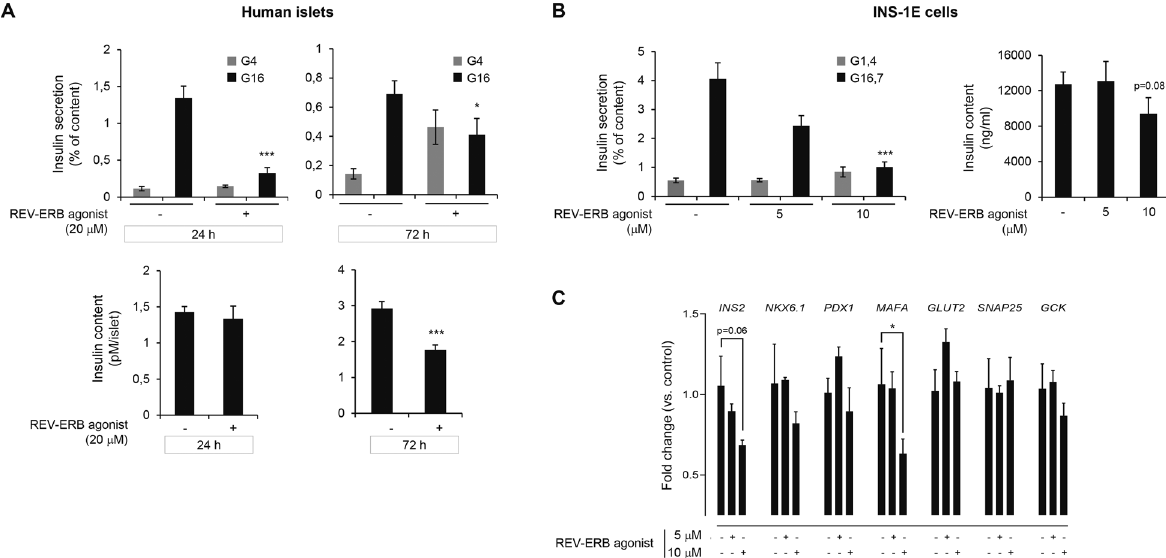
Fig. 5 Pharmacological activation of REV-ERB α attenuates β -cell secretory function. A Isolated human islets were exposed to REV-ERB agonist (SR9009, 20 μ M, for either 24 h or 72 h) or control (DMSO). Following a 30 min quiescent period in Krebs 4 mM glucose (G4), islets were stimulated with 16 mM glucose (G16) for 30 min at 37 °C. The graph represents insulin secretion normalized to insulin content ( n = 7 – 8 independent experiments). The bottom panel represents insulin content in human islets. Data are expressed as mean ± SEM; * P < 0.05, *** P < 0.001 vs. control. B INS-1E cells were exposed to REV-ERB agonist (SR9009, 5 or 10 μ M, 24 h) or control (DMSO). Following a 2 h quiescent period in Krebs 1.4 mM glucose (G1.4), cells were stimulated with 16.7 mM glucose (G16.7) for 1 h at 37 °C; (G1.4 refers to non-stimulated cells). The graph represents insulin secretion normalized to insulin content ( n = 4 independent experiments). The bottom panel represents insulin content in INS-1E cells. C INS-1E cells were exposed to REV-ERB agonist (SR9009, 5 or 10 μ M, 24 h) or control (DMSO). mRNA expression of key β - cell identity and functional genes expressed as fold change relative to control expression ( n = 4 independent experiments per condition). Data are expressed as mean ± SEM; *** P < 0.001, * P < 0.05 vs.